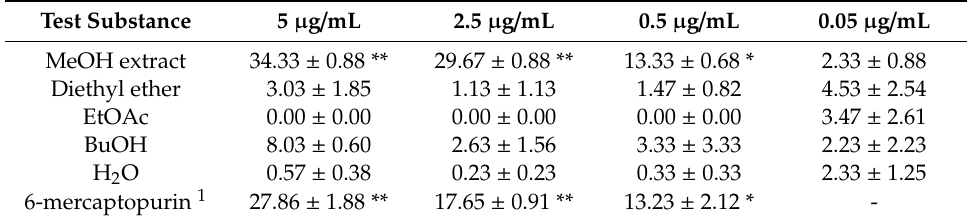
Table 2. % Cellular inhibition of subfractions of the methanolic extract of D. diapensifolia on macrophages after 24 h, evaluated by MTT assay. Data are expressed as mean ± S.E.M (n = 3) of the percentage of cellular mortality vs. control cells. **, * denote p < 0.01, p < 0.05 vs.